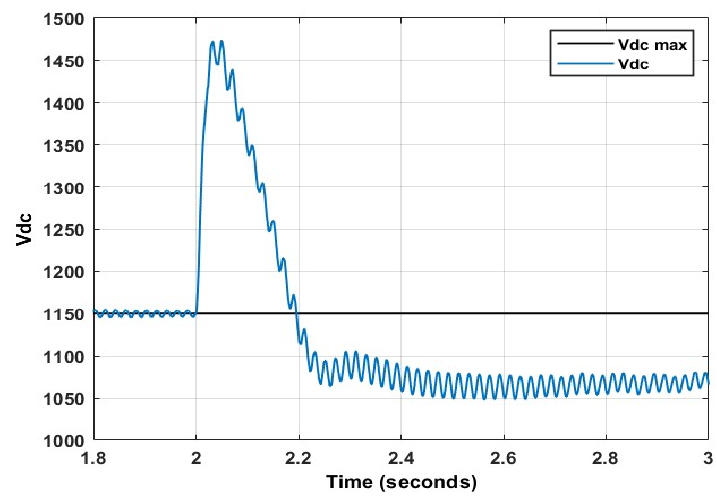
Figure 9. Rotor current transient using PSO at 70% dip.